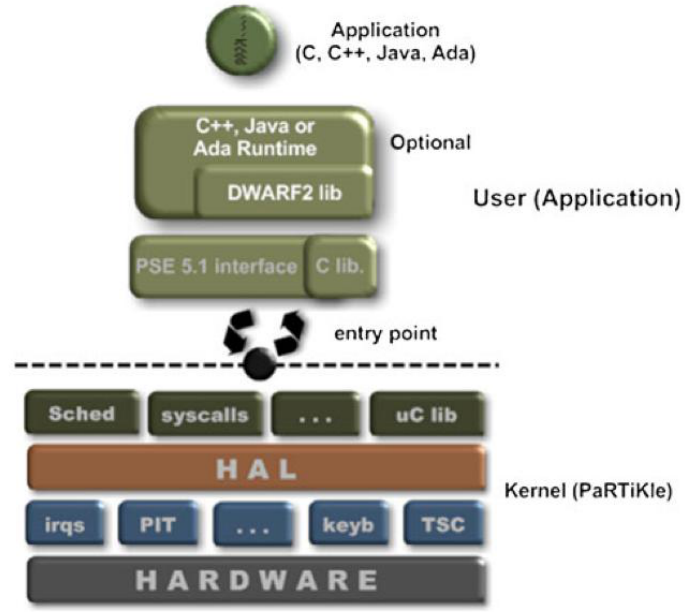
Figure 4. PaRTiKle OS Architecture